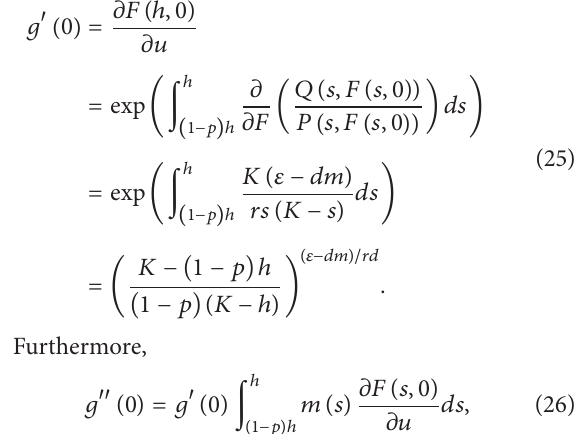
and it can clearly be deduced that 𝜕𝐹(𝐴, 𝑢)/𝜕𝑢 > 0 ,